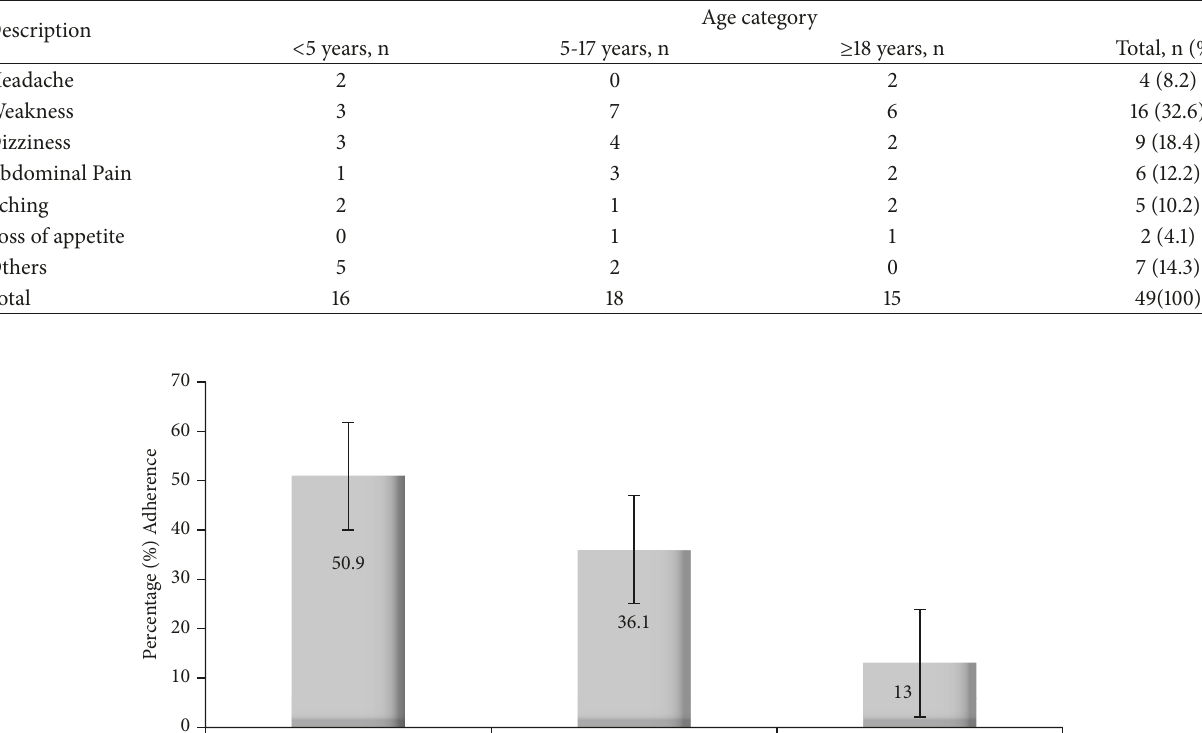
Table 3: Frequencies of adverse events following the DP treatment.